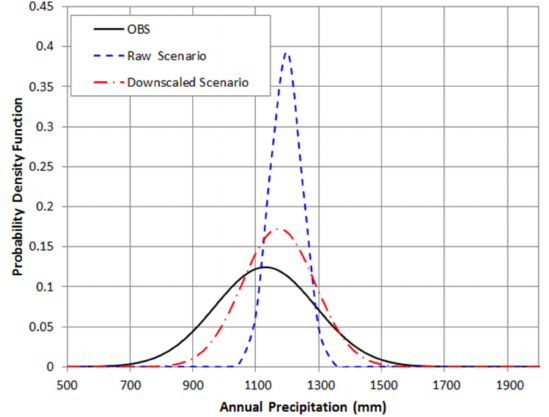
Figure 7. Observation and probability density functions of pre-/post-application of SDQDM (annual